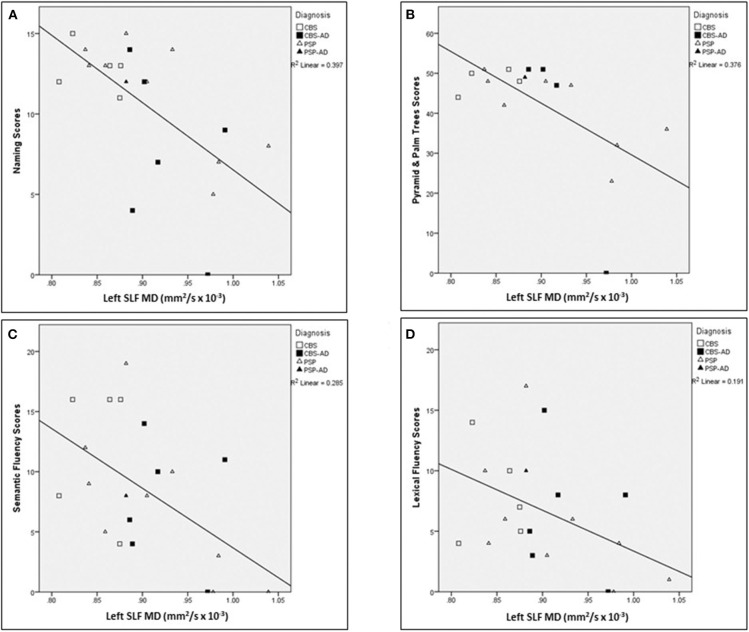
Associations between left SLF MD and language assessments across the whole cohort. Scatter plots presenting associations between left SLF MD (mm2/s × 10−3) and the following language assessments: (A) naming scores, (B) Pyramids and Palm Trees scores, (C) semantic fluency scores, and (D) lexical fluency scores. SLF, Superior longitudinal fasciculus; MD, Mean diffusivity.